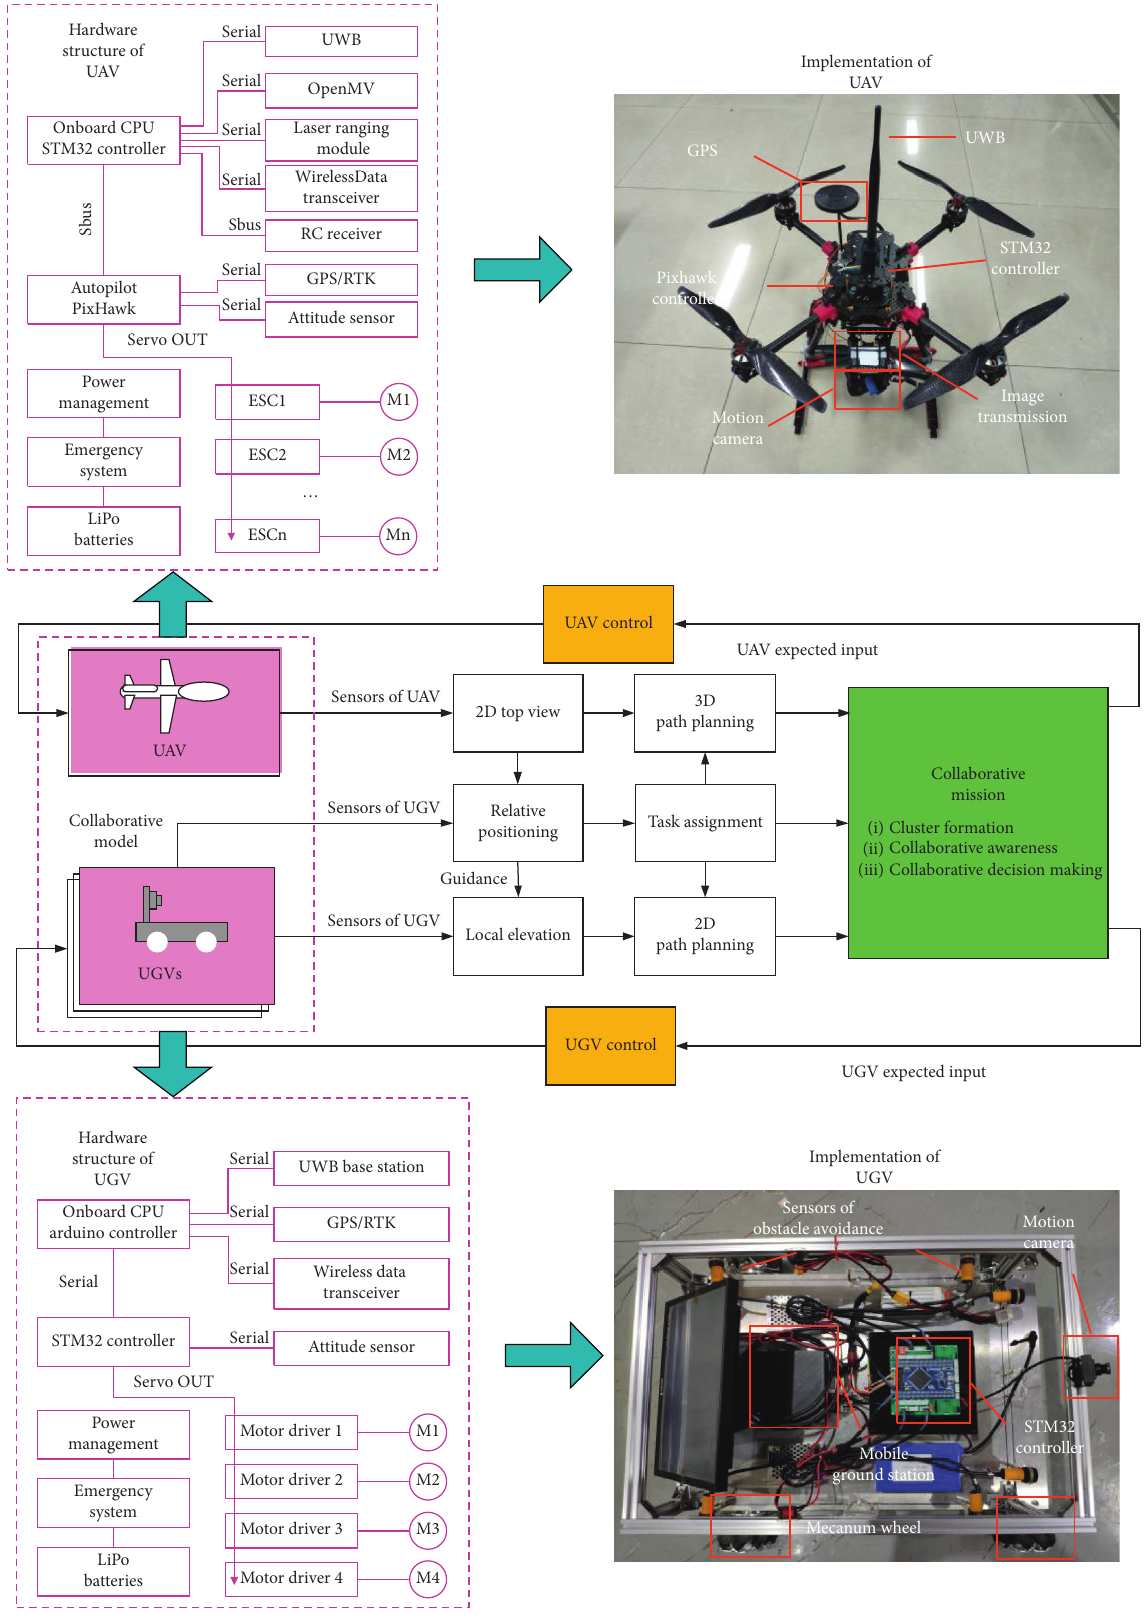
Figure 1: Structure of UAV/UGV heterogeneous system and its implementation of